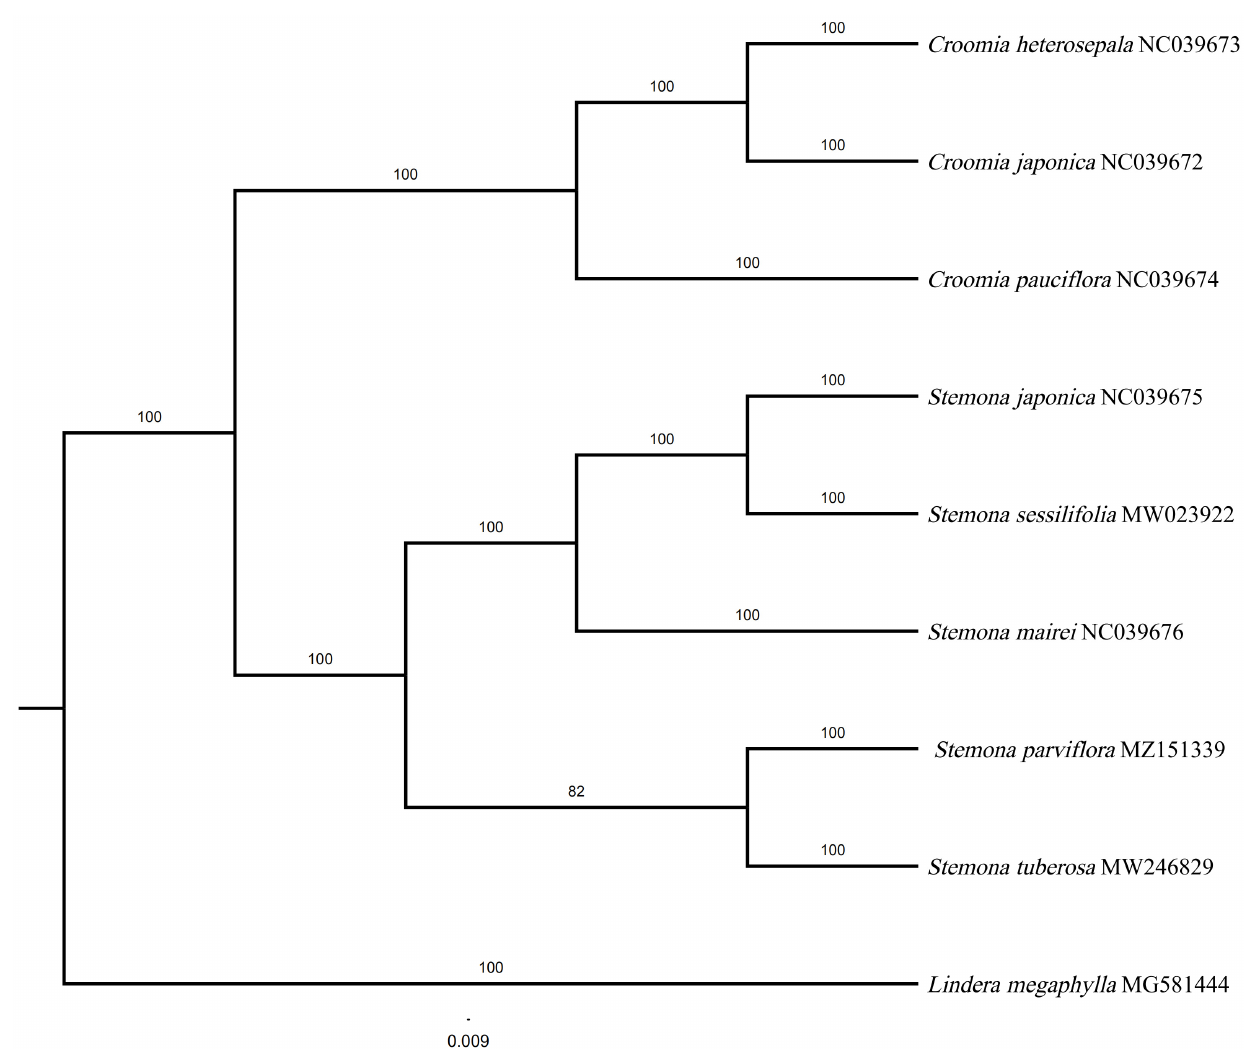
Figure 7. Molecular phylogenetic tree of Stemona using Bayesian inference method.